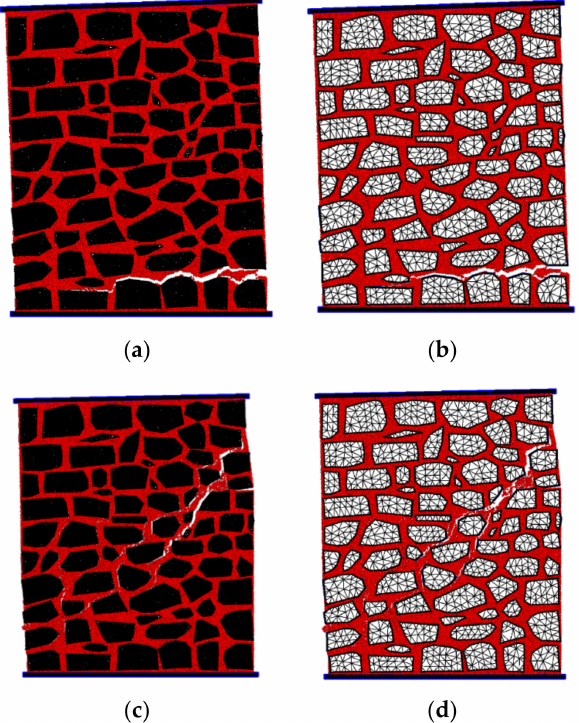
Figure 17. Final displacement field for shear test in rubble wall with initial precompression (magnified